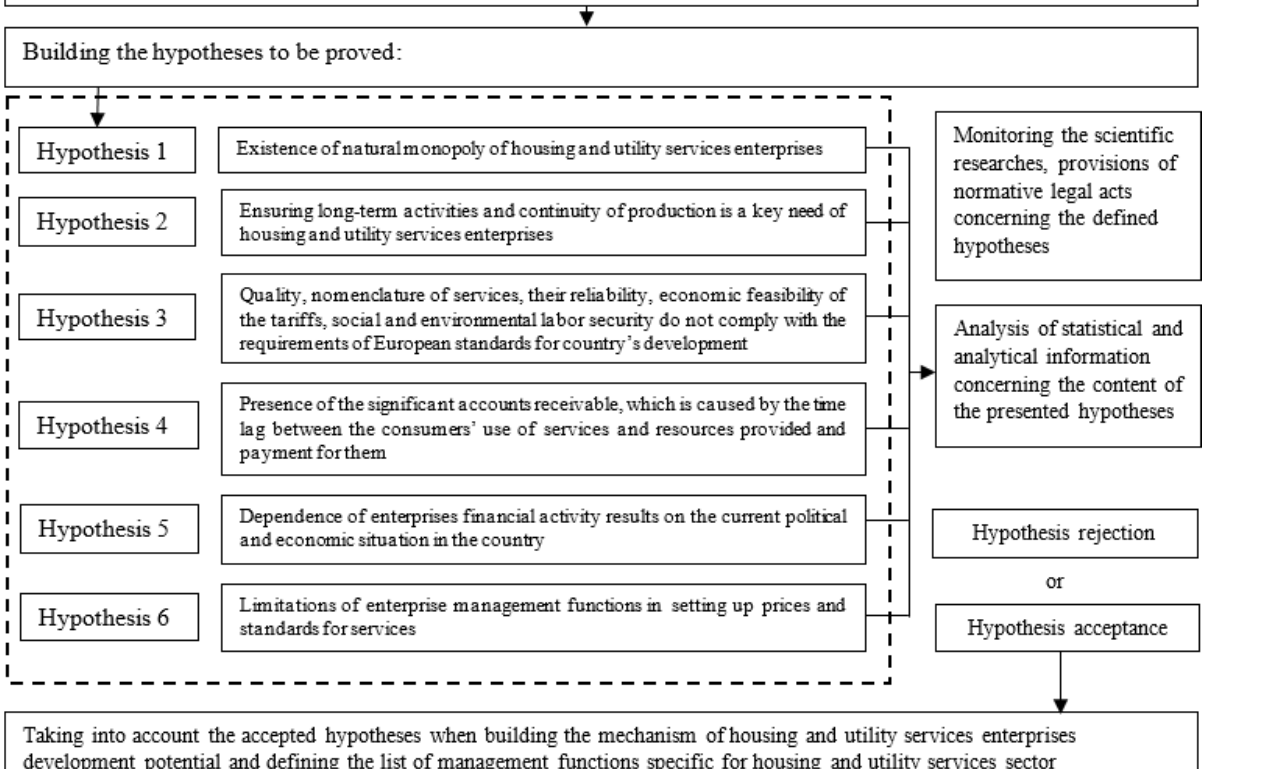
Figure 1. Algorithm of defining the peculiarities of housing and utility services enterprises activity based on method of